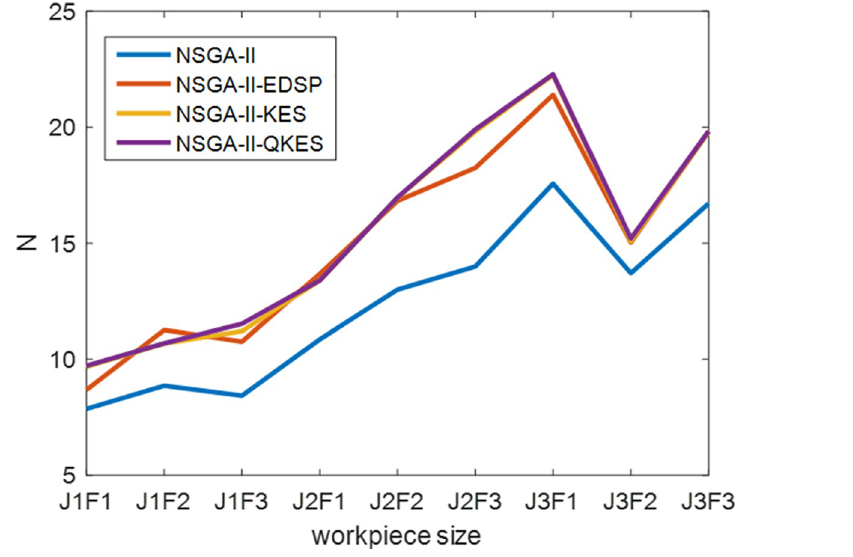
Fig 3. Algorithm comparison